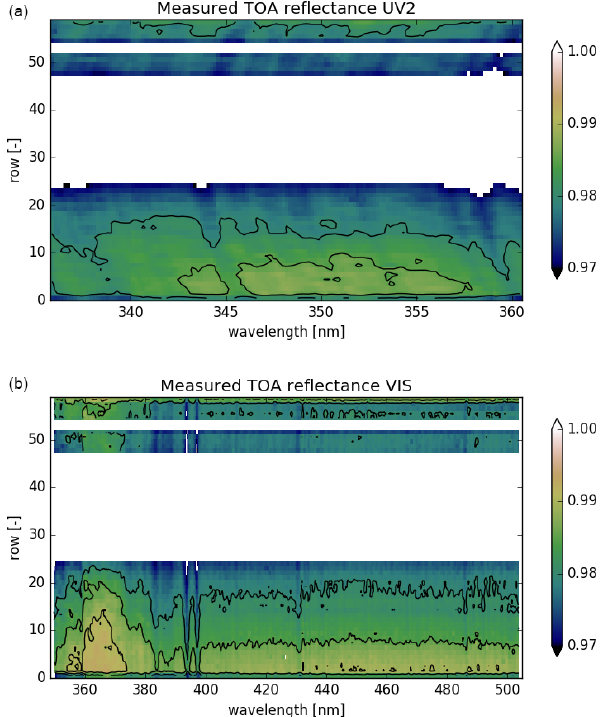
Figure 10. Averaged monthly measurements of TOA reflectances over Antarctica in January 2019 normalized to the same month in 2005 for the UV2 (a) and VIS (b) channels. Detector rows affected by the instrument row anomaly have been